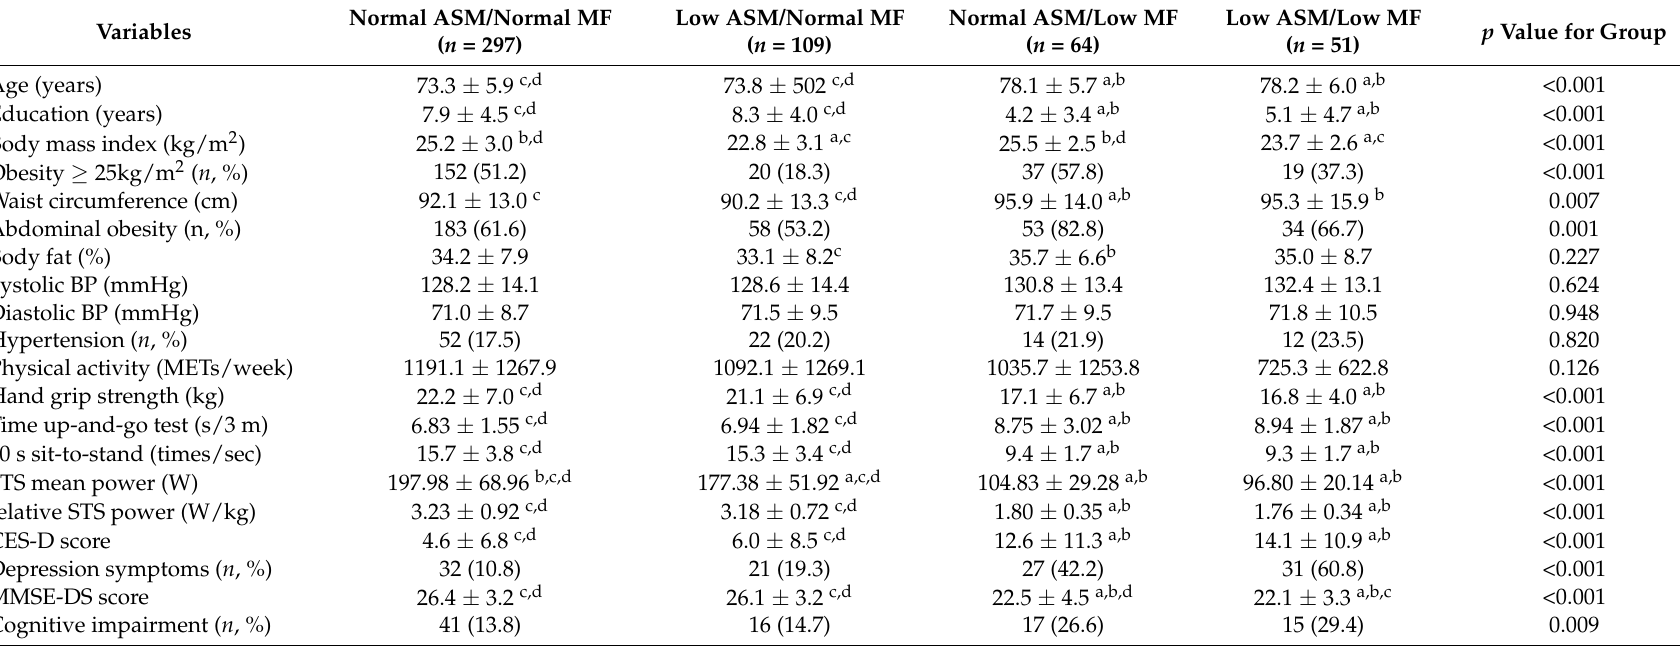
Table 2. Comparison of outcome variables between appendicular skeletal muscle mass (ASM)- and muscle function (MF)-based subgroups.